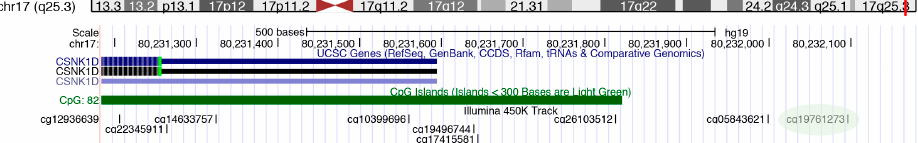
Figure 6. UCSC genome browser view of the genomic location of the CpG cg19761273.